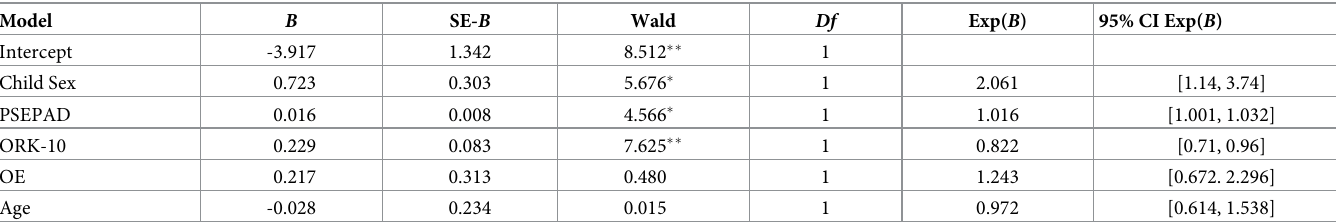
Table 7. Binary logistic regression results of multiple predictors of correct classification of child weight with Likert classification by